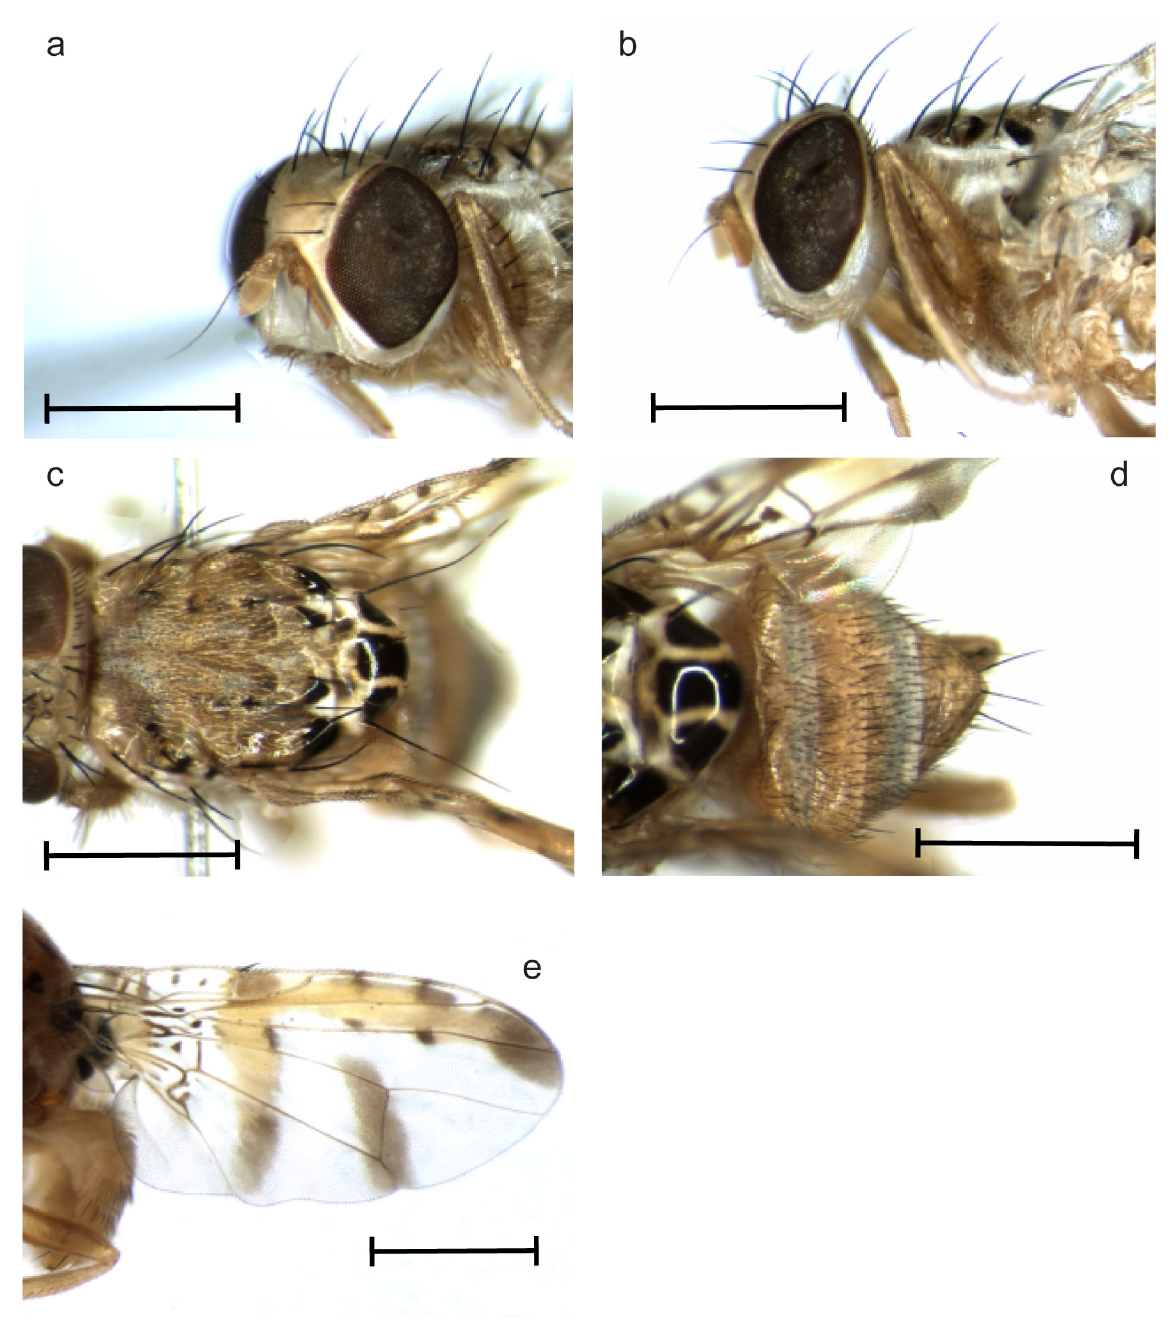
Fig. 2. Ceratitis pallidula De Meyer, Mwatawala & Virgilio sp. nov. a . Head and thorax, anterodorsal view. b . Head and thorax, lateral view. c . thorax, dorsal view. d . abdomen, dorsal view. e . wing. Scale bars = 1